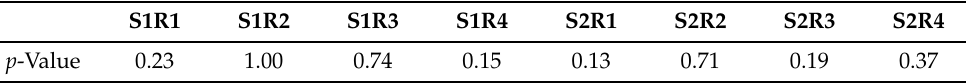
Table 2. p -Value from a Mann–Whitney U test comparing the total energy detected in the impulse response for the iterative and classical algorithms. The results do not show a significant difference between the two data sets for any of the positions.